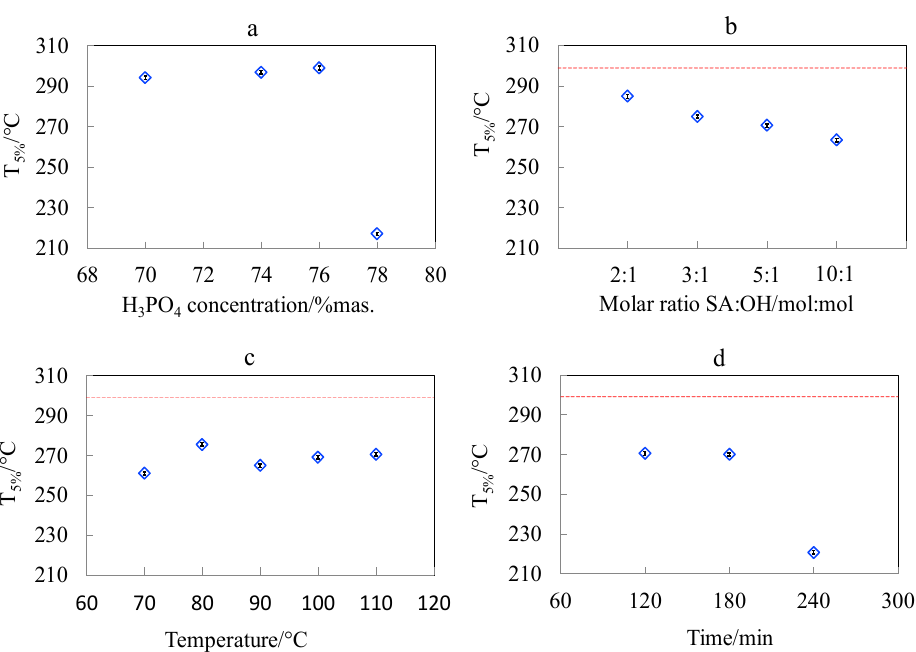
Figure 11. Dependence of the initial temperature of thermo-oxidative degradation (T 5% ) of cellulose nanocrystals ( a ) obtained during hydrolysis at di ff erent concentrations of phosphoric acid; and succinylated cellulose nanocrystals obtained at increasing ( b ) SA:OH molar ratio, ( c ) temperature, and ( d ) time of reaction. Dashed line depicts the T 5% value for the CNC_P76 nanocrystals subjected to surface esterification.